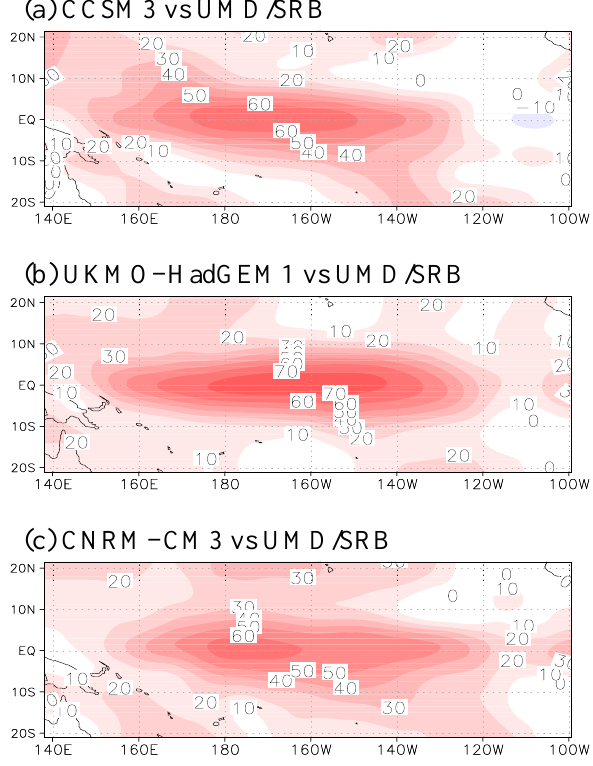
Fig. 3. Correlation patterns between SW ↓ surf from AMIP II mod- els versus UMD/SRB estimates in (%): (a) CCSM3; (b) UKMO- HadGEM1; (c)